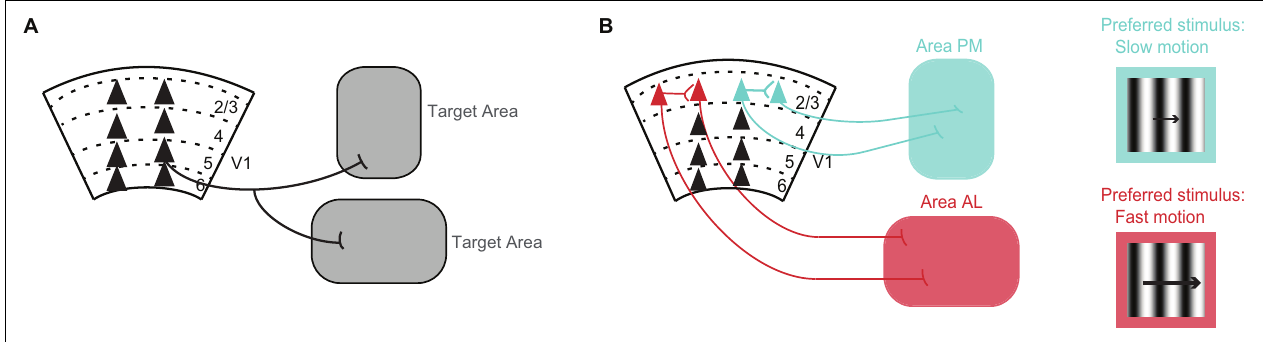
FIGURE 1 | Organization of V1 projections. (A) Axons of most V1 neurons target multiple brain areas (Han et al., 2018). Triangles represent cell bodies, lines indicate axons. Numbers and dashed lines mark the different layers of V1. (B) V1 neurons projecting to visual cortical area PM (blue) and V1 neurons projecting to visual cortical area AL (red) avoid making local connections with each other within V1 (Kim et al., 2018). Conventions as in A. V1 neurons projecting to area PM (blue) prefer, i.e., fire the most spikes for, the slower moving stimuli, while V1 neurons projecting to area AL (red) prefer faster moving stimuli (Kim et al., 2018). The same preference is seen in V1 axons projecting to these areas from layer 5 (Glickfeld et al., 2013a). The drifting grating represents the visual stimulus. The length of the arrow is proportional to speed.